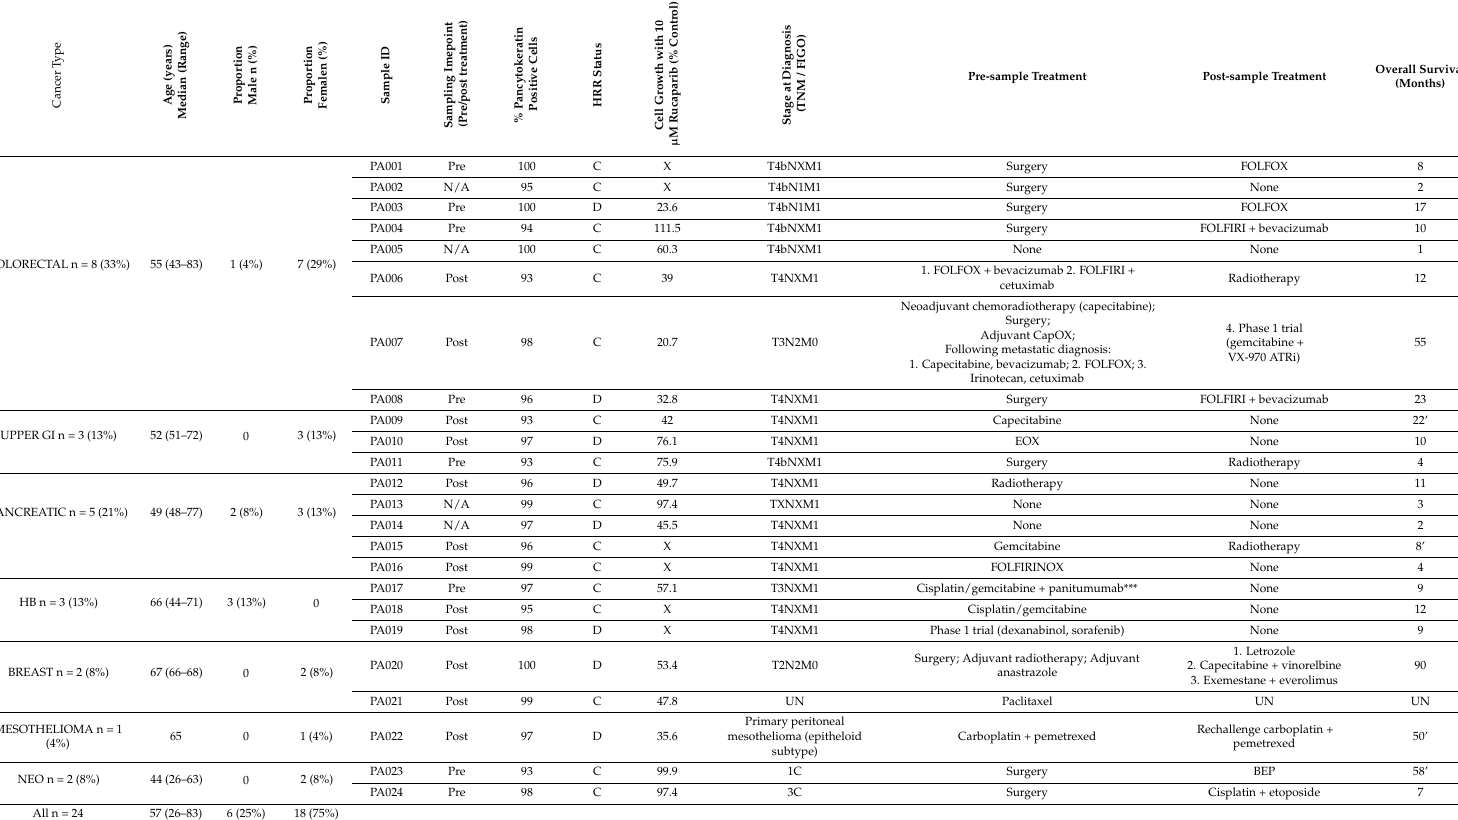
Table 1. Clinical data for all 24 established cultures. Patient characteristics, ascites sample details and pre-sampling and post-sampling treatment data. Homologous recombination DNA repair (HRR)-competent samples are denoted as C, and HRR-deficient samples are denoted as D. Where cytotoxicity to poly(ADP-ribose) polymerase inhibitors (PARPi) was not determined, samples are marked with an X. Overall survival (OS) was calculated as the time (months) elapsed from the date of diagnosis to the date of death, OS figures denoted with ‘ are censored patients that were alive at last review. ***This patient received panitumumab as part of an overseas